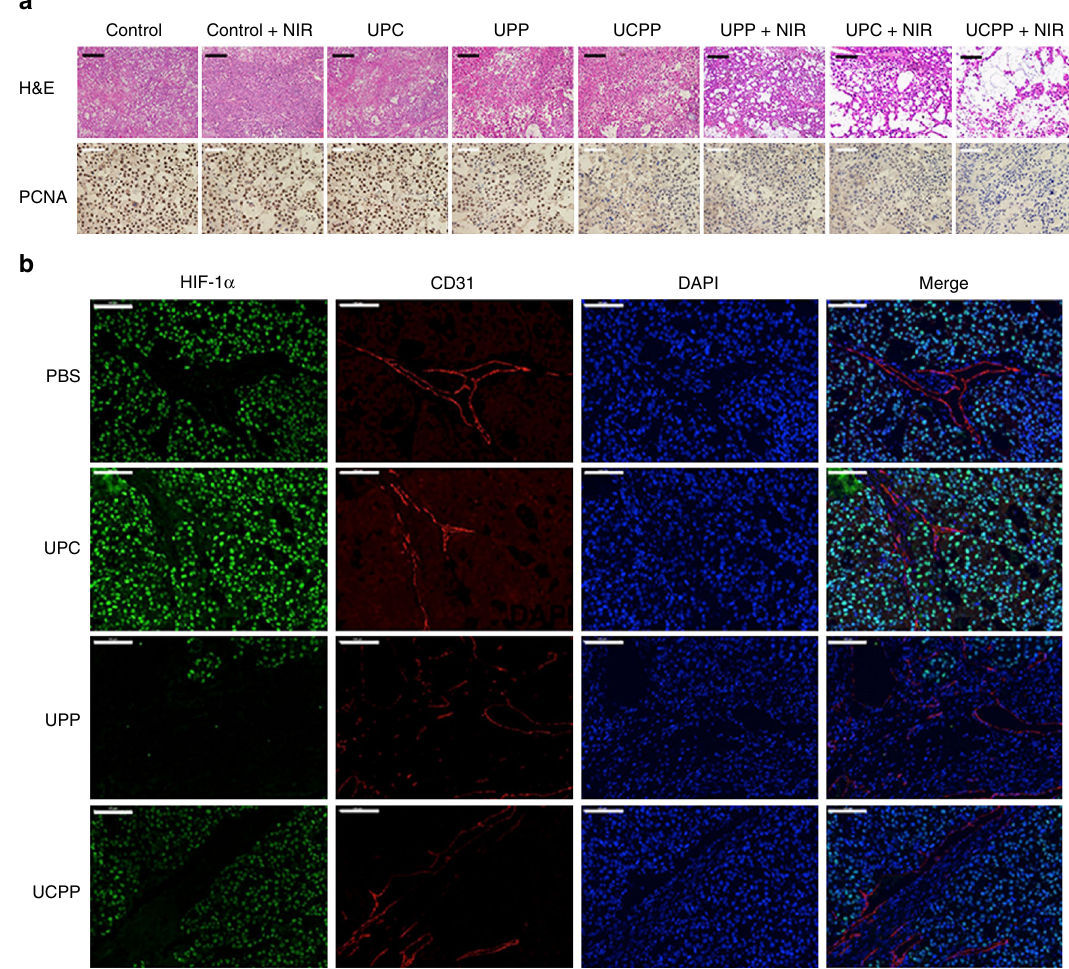
Fig. 5 In vivo studies of anticancer ef fi cacy and hypoxia reversion. a H&E and PCNA stained HeLa tumor slices from different groups collected 24 h after one single injection and light irradiation respectively (magni fi cation × 200). The scale bars represent 100 μ m. b Representative immuno fl uorescence staining of HIF-1 α (green) and CD31 (red) on HeLa tumor slices collected 24 h after one single injection and light irradiation (magni fi cation × 200). The scale bars represent 100 μ